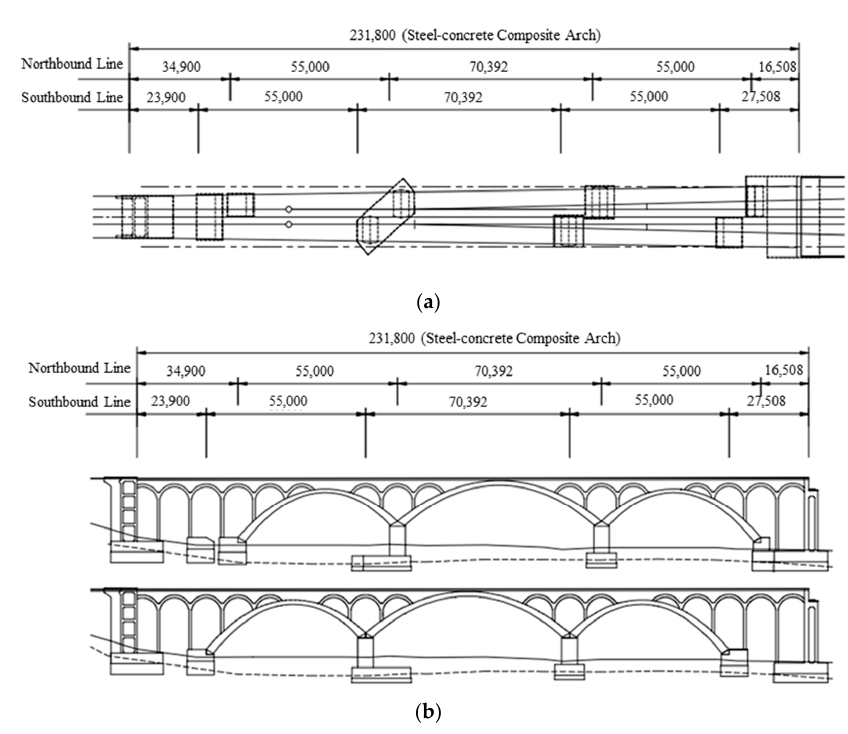
Figure 2. Design drawings of Eonyang Arch Bridge: ( a ) plan view; ( b ) front view.